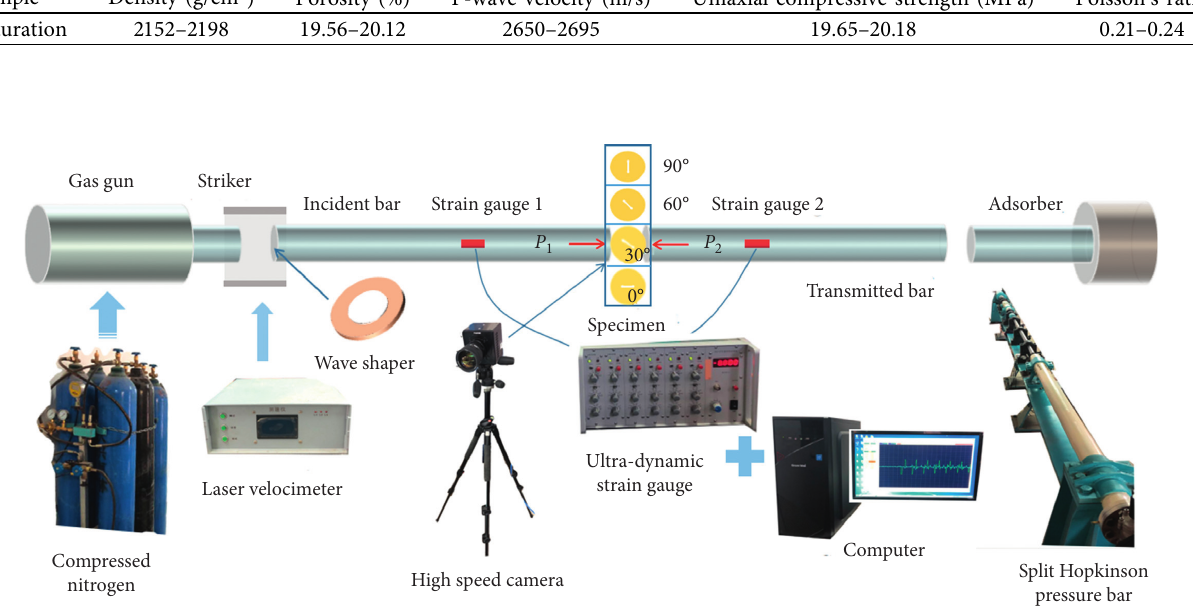
Figure 2: Diagram of the SHPB test system.